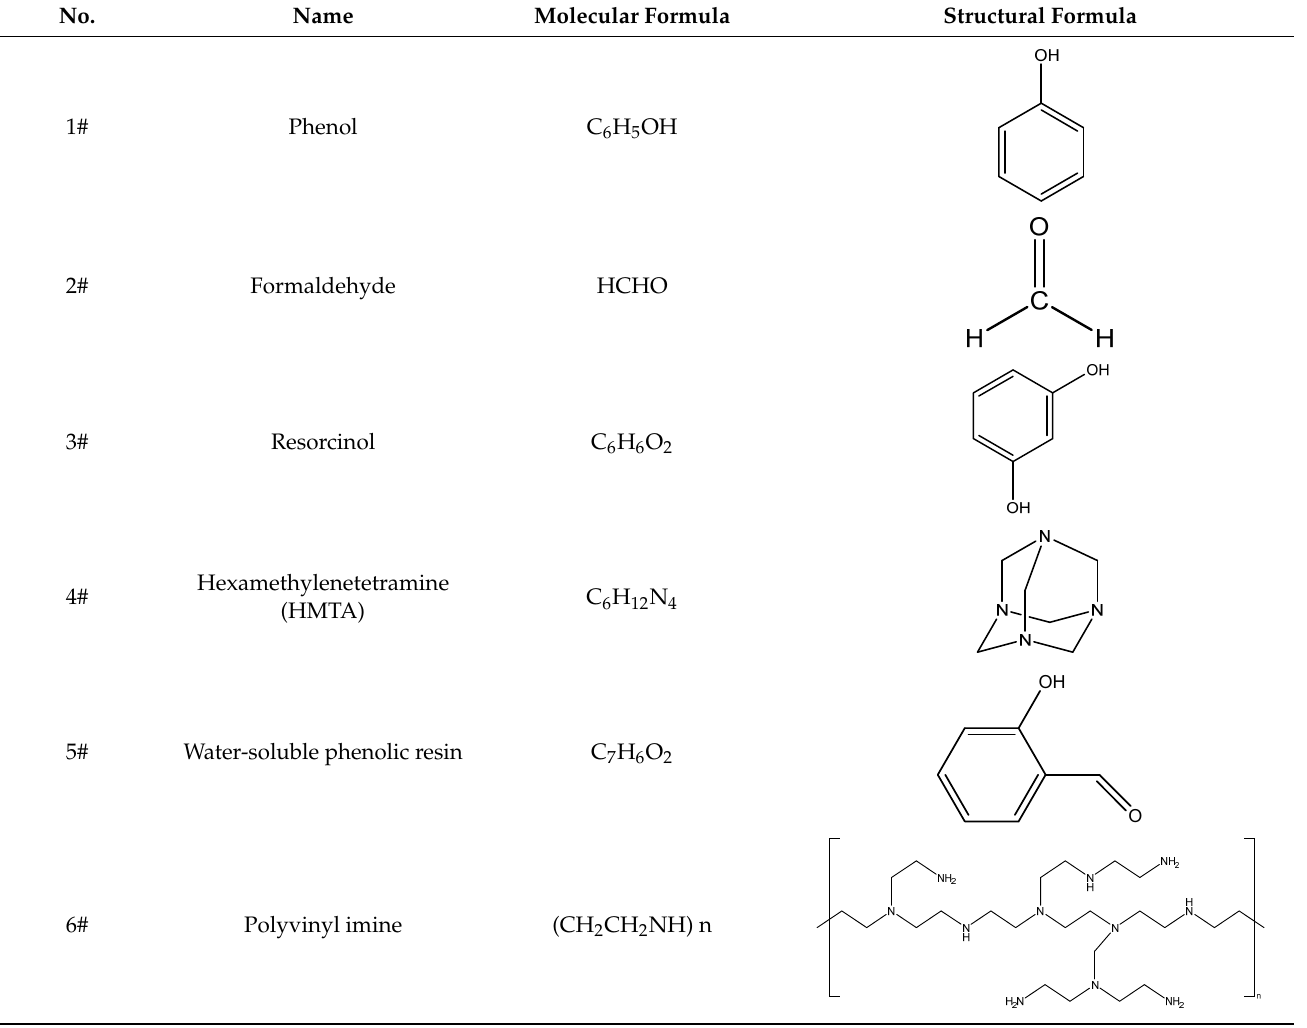
Table 2. Commonly used crosslinkers for covalent organic crosslinked gels.